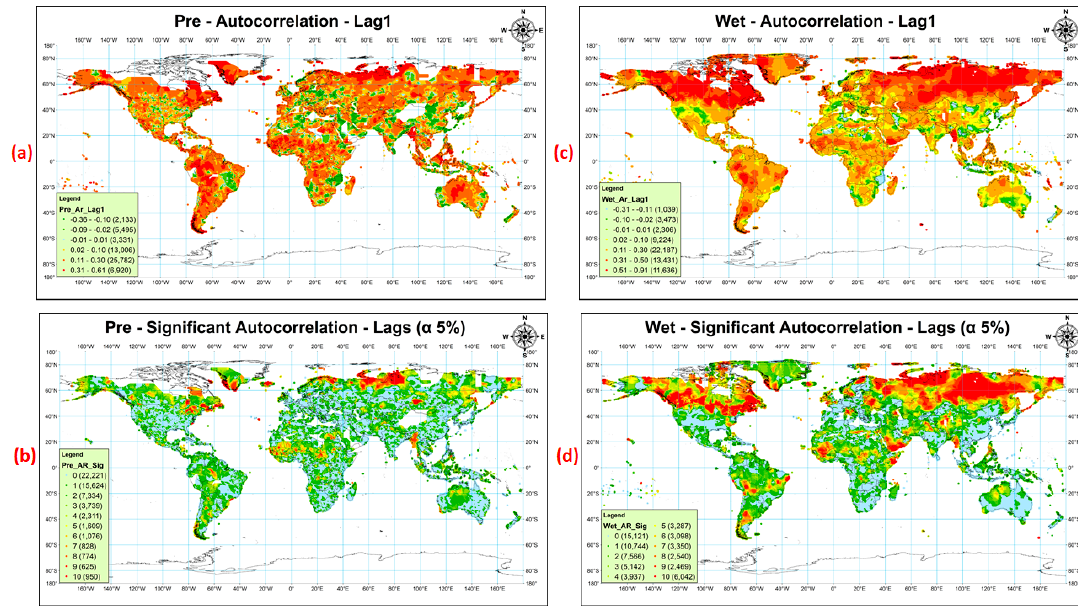
Figure 1. Lag1 autocorrelation and significant autocorrelation up to lag10 of annual Pre ( a , b ) and Wet ( c , d ), respectively. Lag1 autocorrelation for Pre and Wet data ( a , c ) is divided to show the variation from lower to higher magnitude in either direction. The autocorrelation close to 0 (up to 0.01, positive or negative) is marked by cyan color. The darker shades of the green and red show an increasingly higher amount of negative and positive autocorrelation.